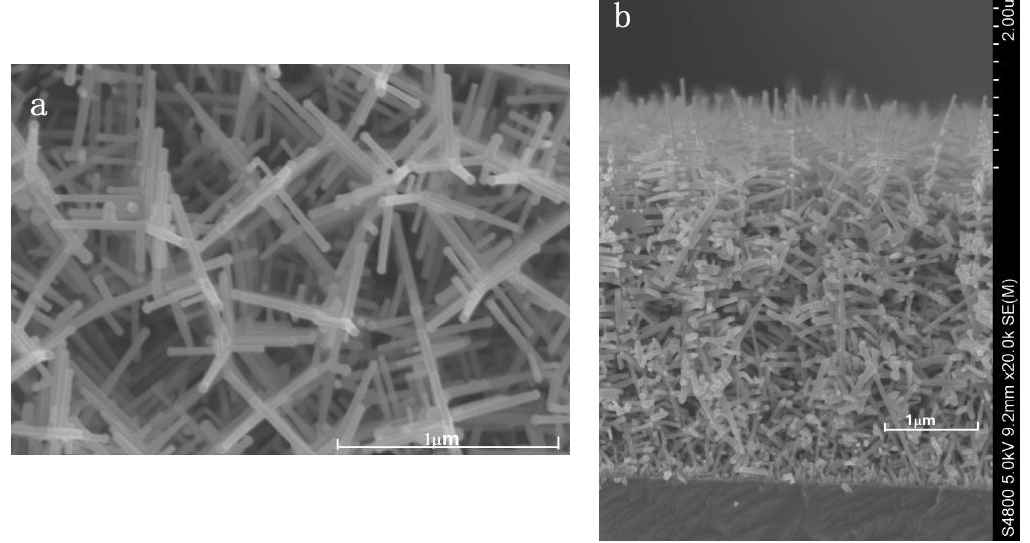
Figure 1. SEM micrographs of ITO films fabricated at a substrate temperature of 300 °C: ( a ) top view; ( b ) profile.